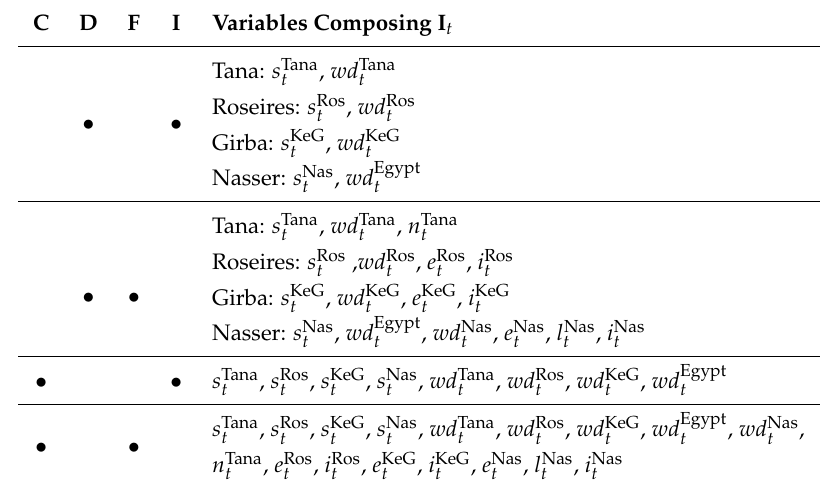
Table 2. Variables given as input to the control laws for the four considered cases: centralized-full